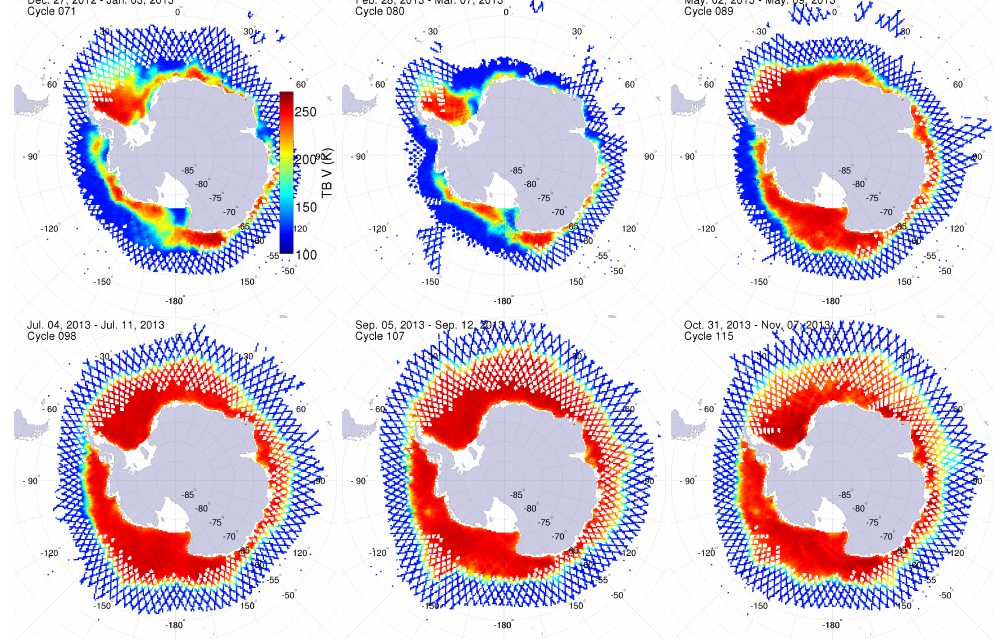
Fig. 10. Maps of TB (radiometer 3) at V polarization over the SH sea ice every two months in 2013. Grid cells where the land fraction was more than 0.25 were masked.